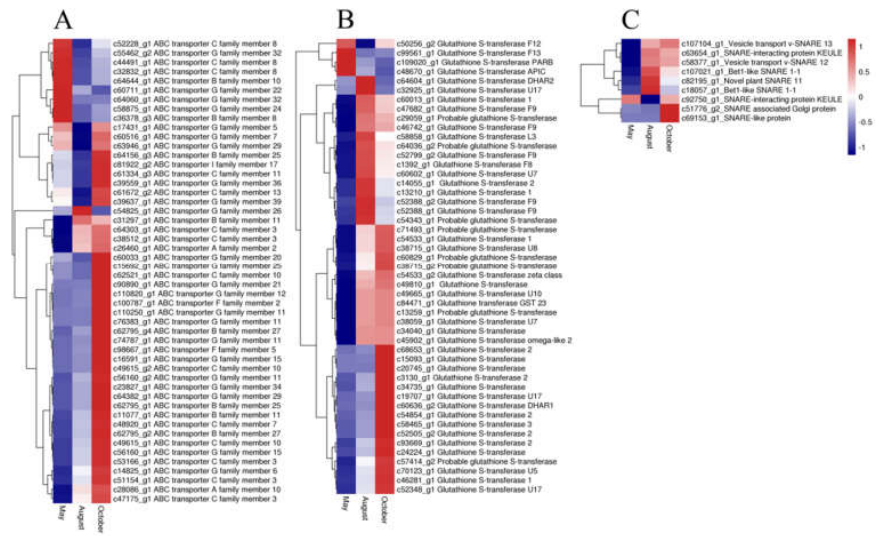
Figure 8. The expression level of DEGs of ATP binding cassette (ABC) transporter ( A ), glutathione S-transferase (GST) ( B ), and soluble N -ethylmaleimide-sensitive factor attachment protein receptor (SNARE) ( C ) genes. Blue and red colors represent different levels of gene expression and the color scales reflect a log 2 -transformed mean of FPKM values. Molecules 2019 , 24 , 1267